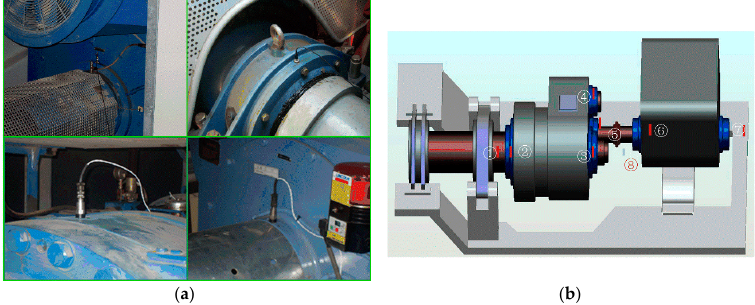
Figure 10. ( a ) Experimental setup; ( b ) Schematic of the sensor distribution on drivetrain of the wind turbine.